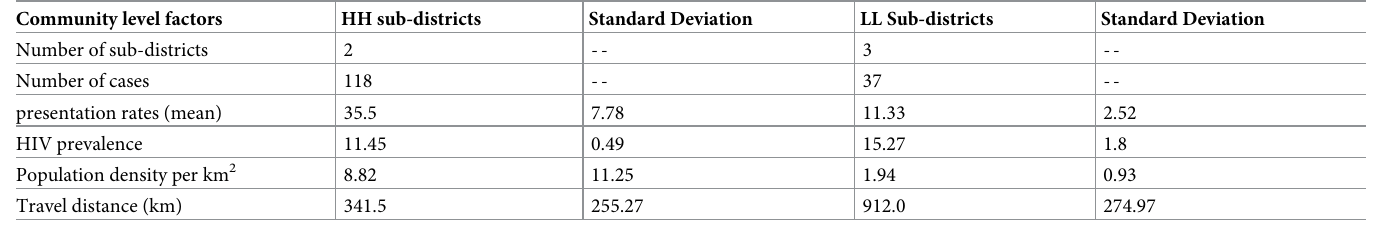
Table 3. Community level factors for identified High-High (HH) and Low-Low (LL) sub-districts. Community level